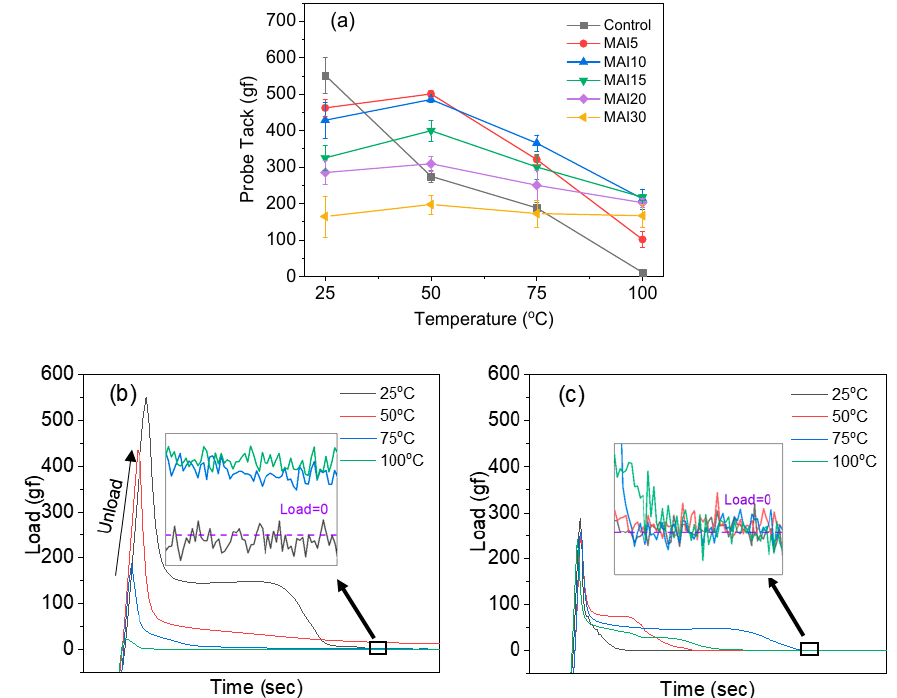
Figure 4. Probe tack of SPSAs as a function of temperature ( a ), probe tack curves of control ( b ), and MAI20 ( c ).